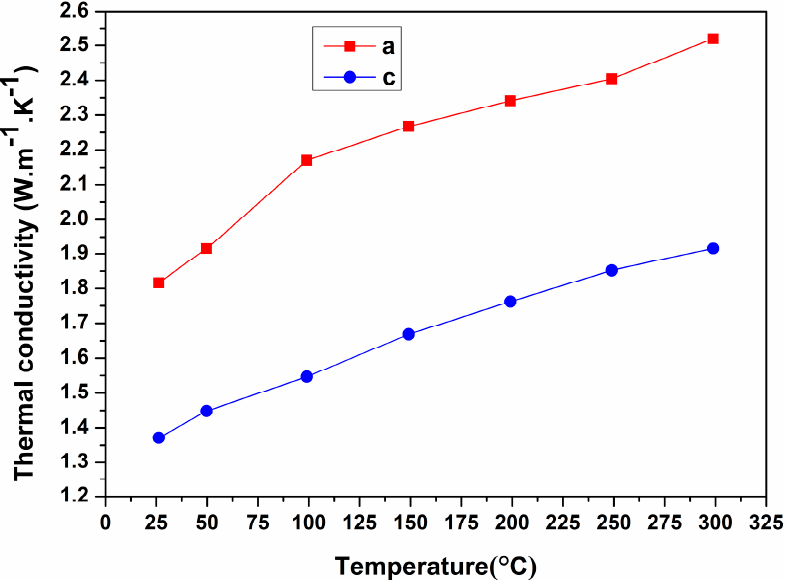
Figure 3. The thermal conductivity of CYAM crystal along a and c Figure 3 The thermal conductivity of CYAM crystal along a and c axes. Figure 3 The thermal conductivity of CYAM crystal along a and c axes.